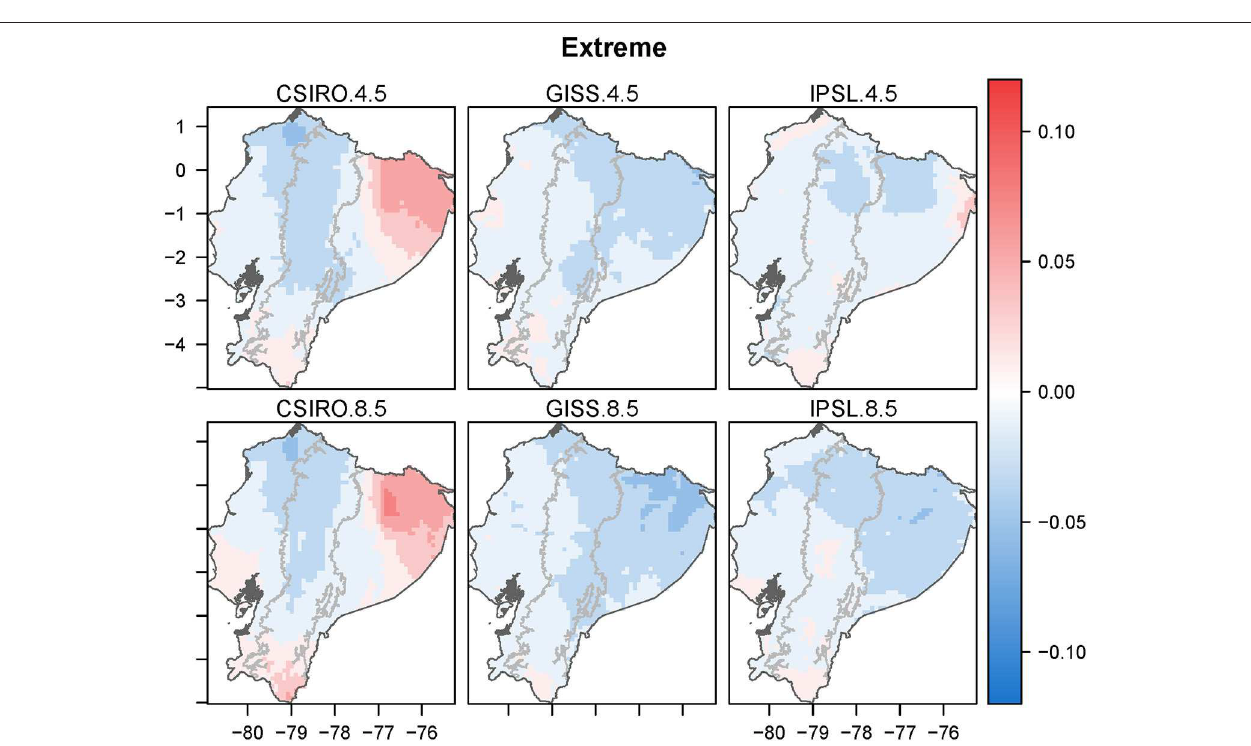
FIGURE 6 | Spatial distribution of change for extreme drought probability. RCP (rows) and GCM (columns). White pixels indicate no change.